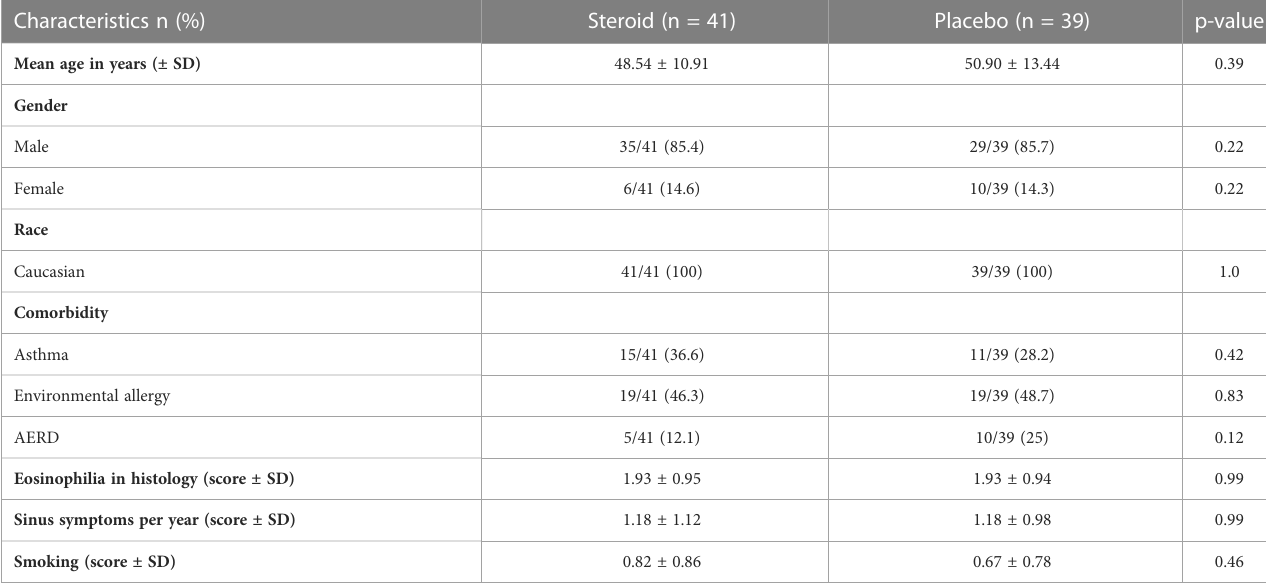
TABLE 1 Patient demographics of the intention-to-treat group (n=80) showing no signi fi cant differences between the steroid and the placebo group. Characteristics n (%)